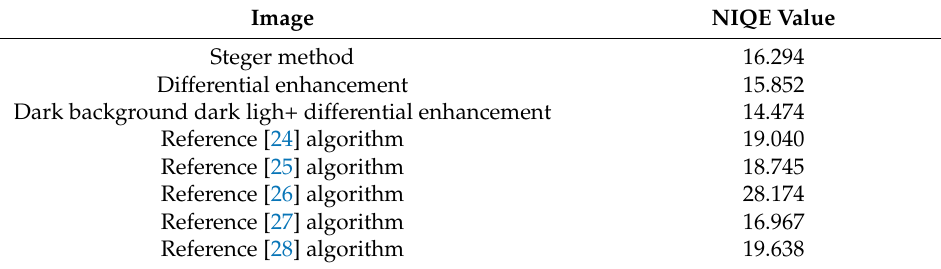
Table 3. Each algorithm process metal roller image NIQE value. Image NIQE Value Steger